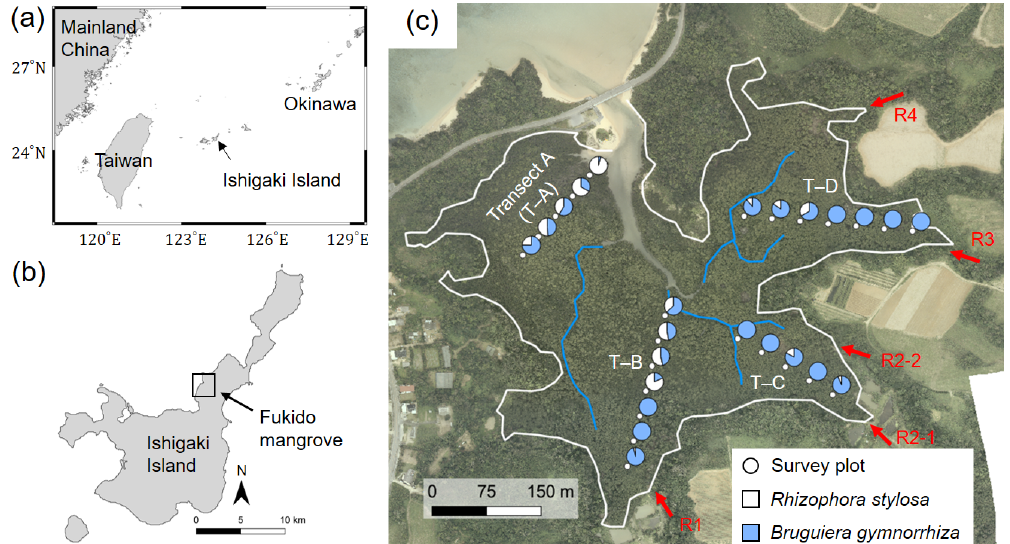
Figure 1. (a) Location of Ishigaki Island; (b) location and (c) aerial photo of the study site – Fukido mangrove forest. The white line in panel (c) indicates the boundary of mangroves and other land covers where mangroves are assumed to inhabit the areas of eleva- tion < 1.0m + mean sea level, which was delineated based on a lidar-derived digital elevation model (DEM). The blue lines indicate small creeks. The circular makers indicate survey plots’ locations along with four transects (T–A to T–D), while the pie charts indicate species composition in each plot. The red arrows indicate outlets of rivers flowing into the mangrove forest (R1 to R4). The aerial photo and DEM products were obtained from Asia Air Survey Co. Ltd., Japan. Shorelines are from Global Self-consistent, Hierarchical, High-resolution Geography Database